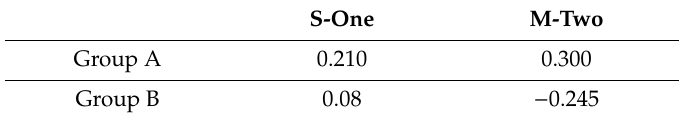
Table 3. Values of torque